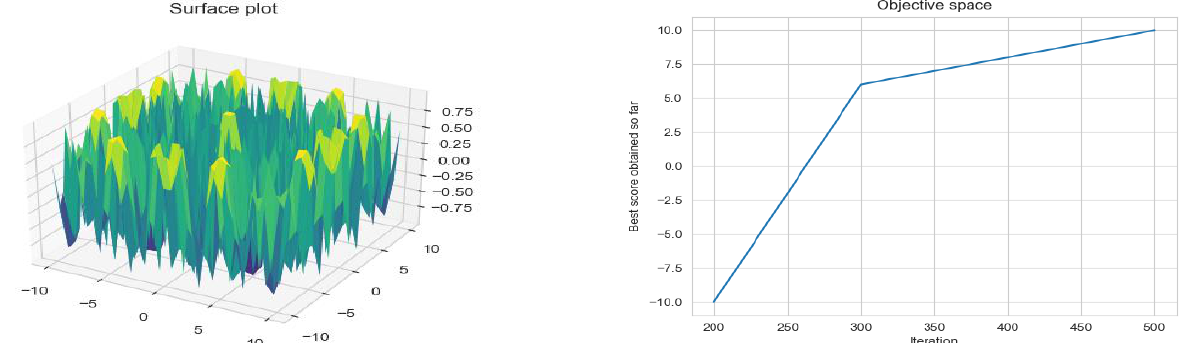
Figure 8. For function-F2 convergence curve has shown.